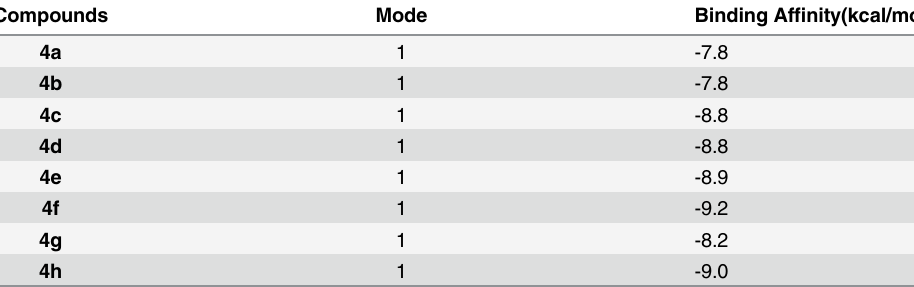
Table 3. The binding Affinities of the penicillin derivatives (4a-h).